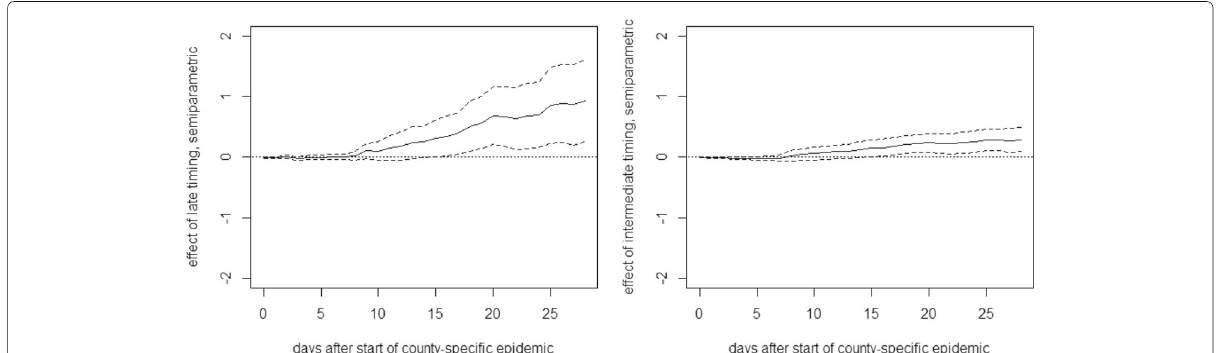
Fig. 4 DR effects of late (left) and intermediate (right) timing of measures on cumulative deaths per 10,000 inhabitants in Germany